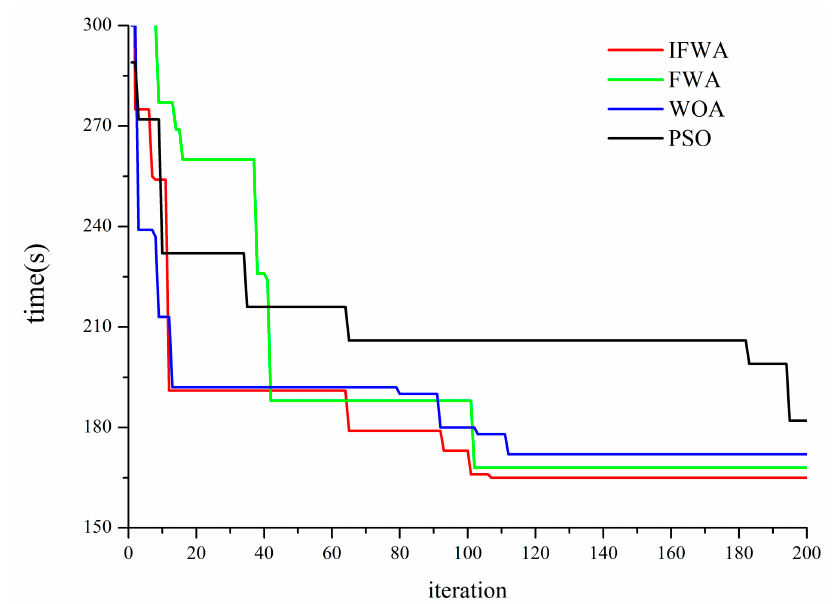
Figure 6. The optimal curves of the four algorithms.